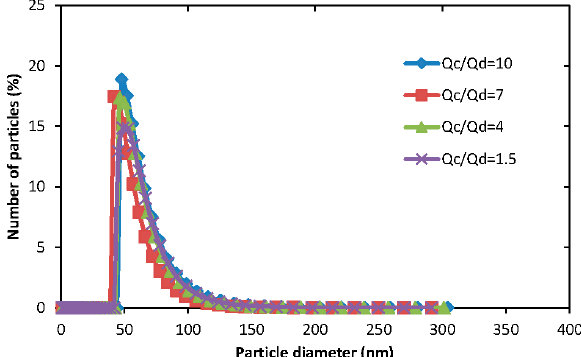
Figure 8. The particle size distribution of micelles generated from the same co-flow microfluidic device with an orifice diameter of 160 μ m at different aqueous/organic flow rates ratios, Q a /Q o . Aqueous phase flow rates Q a were fixed to 5 mL·h − 1 for all four experiments. The organic phase was composed of 1 mg·mL − 1 of PEG- b -PCL (B) dissolved in acetone.